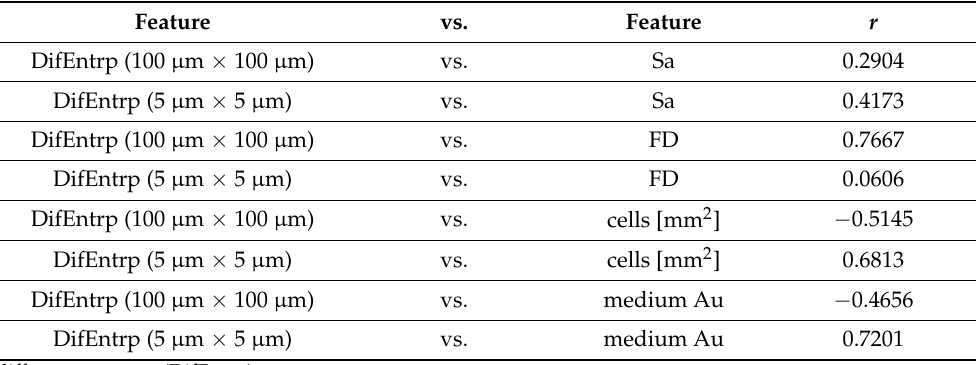
Table 8. The values of the Pearson correlation coefficient ( r ) between the value of difference entropy (DifEntrp) calculated in different scales (100 µ m × 100 µ m and 5 µ m × 5 µ m) and the Sa and number of cells per mm 2 and medium Au. No statistically significant relations were found. Feature vs. Feature r